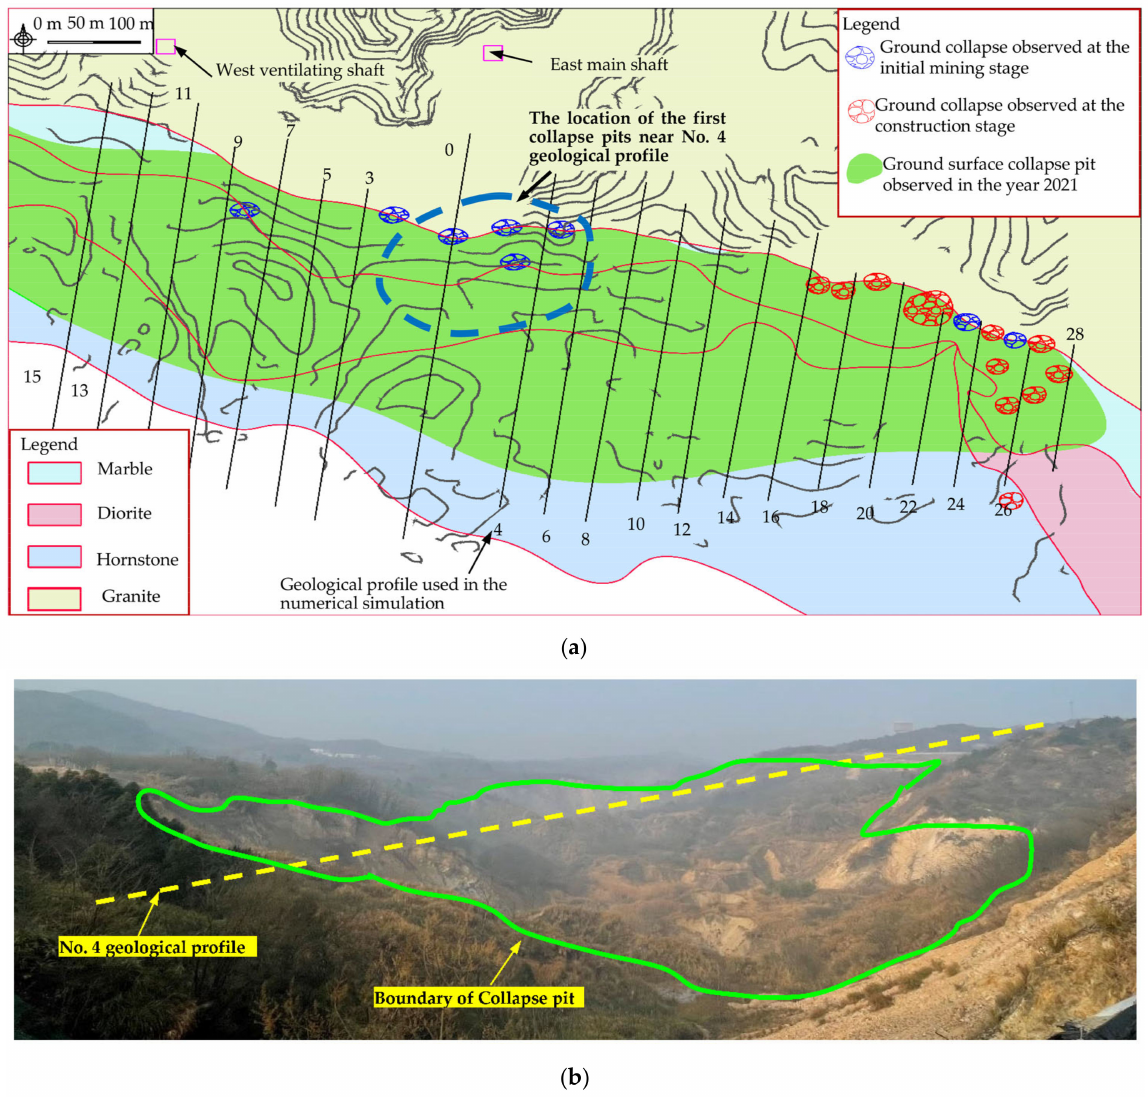
Figure 11. ( a ) Distribution of the ground surface collapse pits in the eastern area of the Chengchao Iron Mine at different mining stages (numbers near the exploratory lines are the names of the geological profiles); ( b ) photograph of the collapsed ground (taken on 26 August